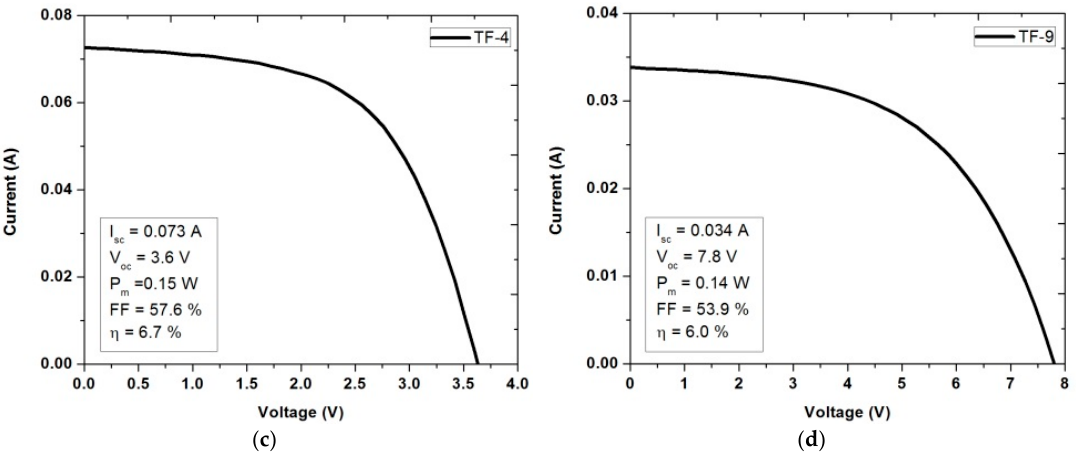
Figure 2. I-V characteristics of: ( a ) TF-1; ( b ) TF-3; ( c ) TF-4; and ( d ) TF-9 modules. Table 1. Electrical characteristic parameters of a-Si PV modules.